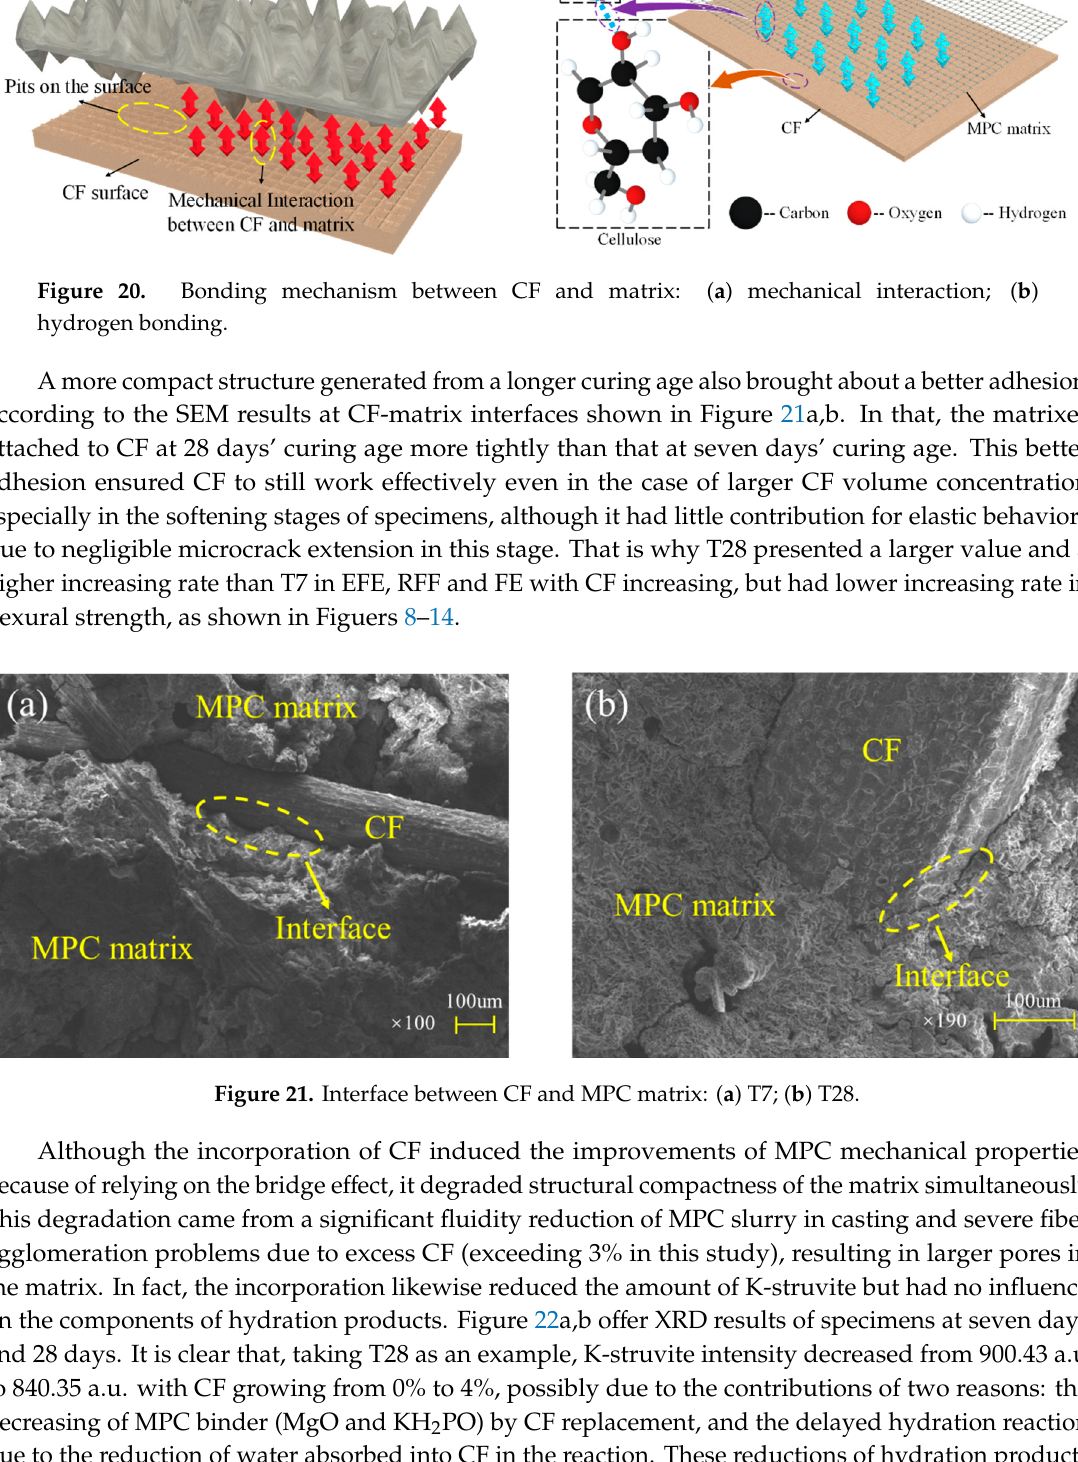
Figure 19. SEM and XRD for CF: ( a ) untreated CF; ( b ) treated CF.